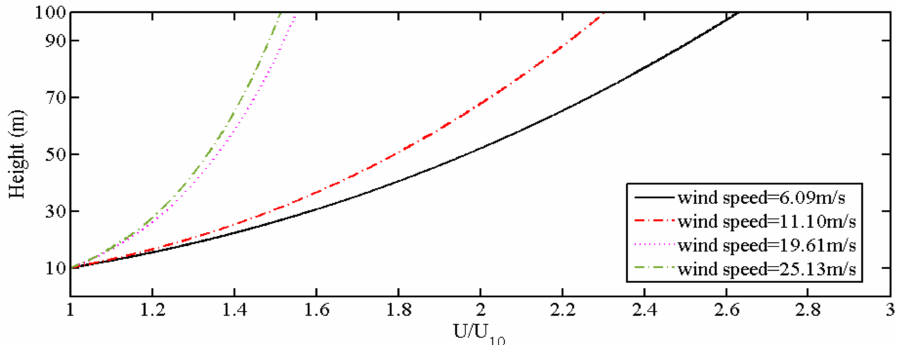
Figure 11. Wind profile parameters with different wind speeds.